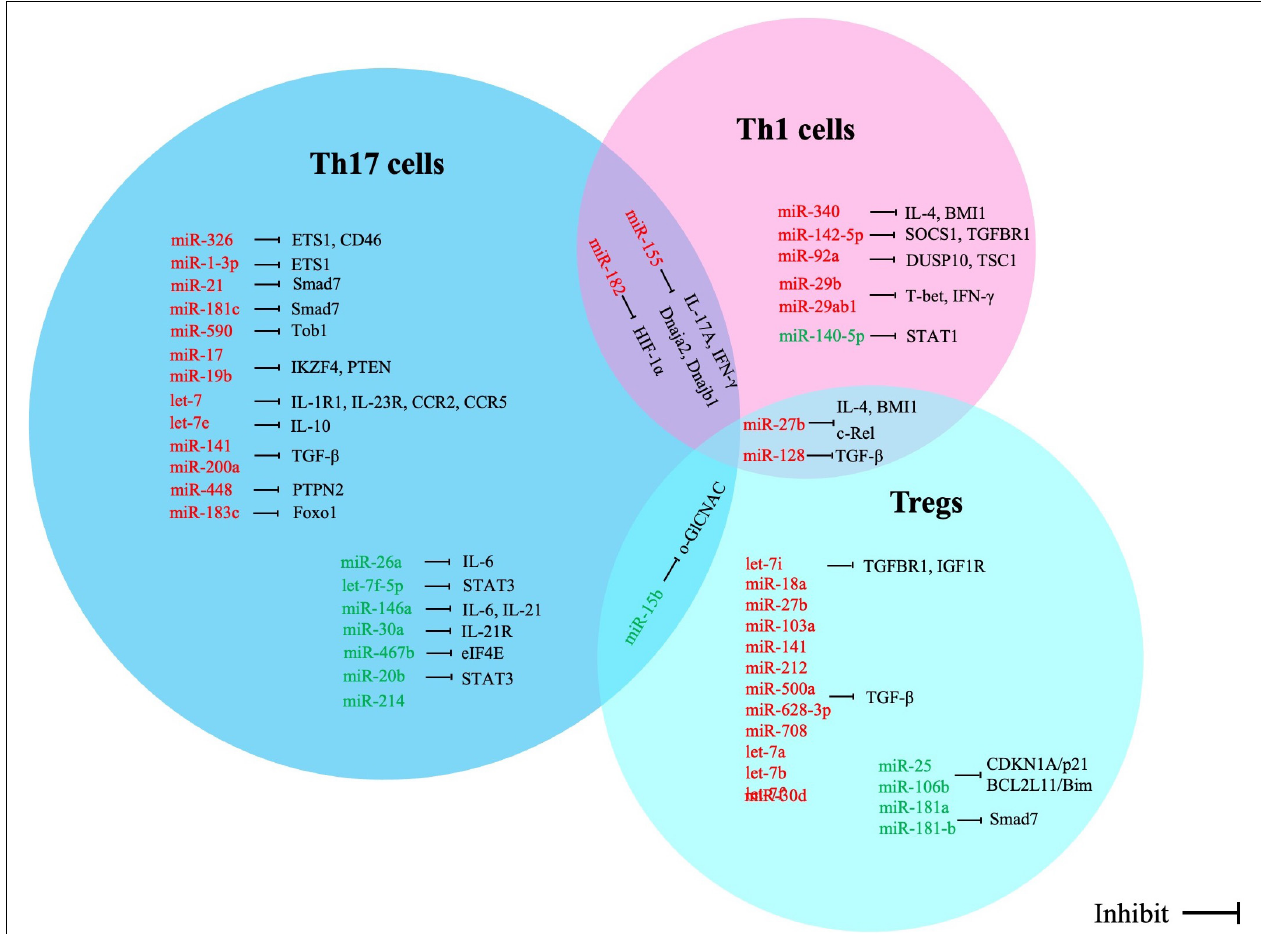
FIGURE 1 | Correlation between miRNA alterations and expression of direct targets in T cell subsets of multiple sclerosis. Red words indicate the up-regulated miRNAs and green words indicate the down-regulated